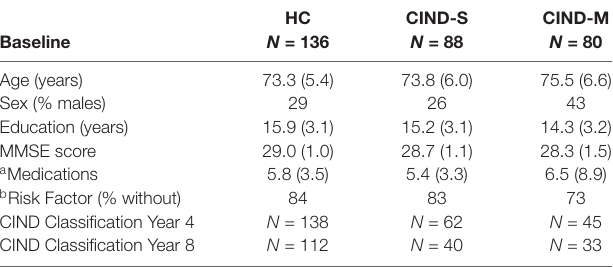
TABLE 1 | Sample characteristics as a function of baseline cognitive